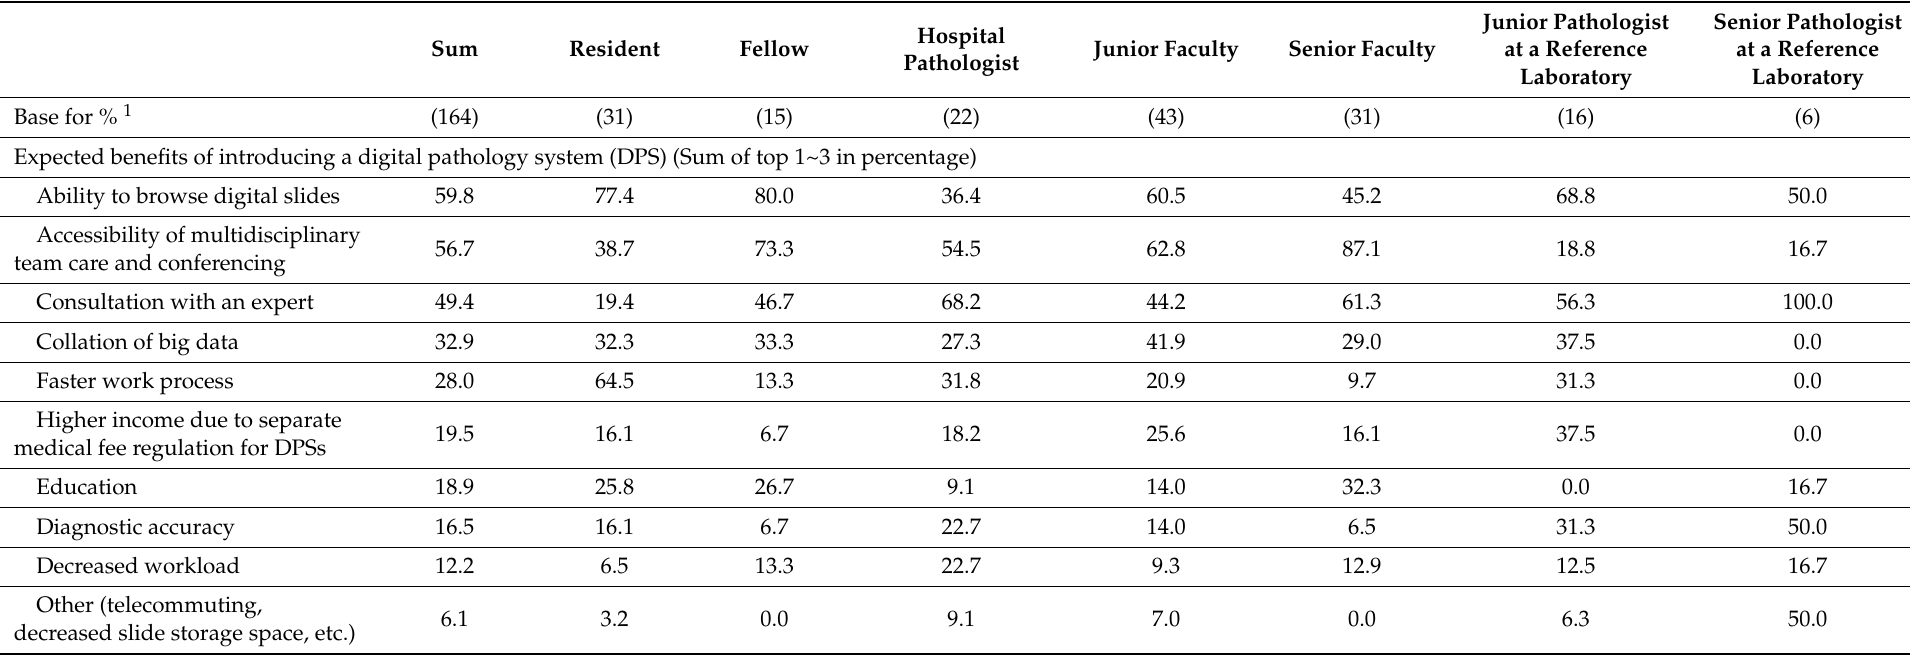
Table 2. Expected benefits of introducing a digital pathology system (DPS) by career and